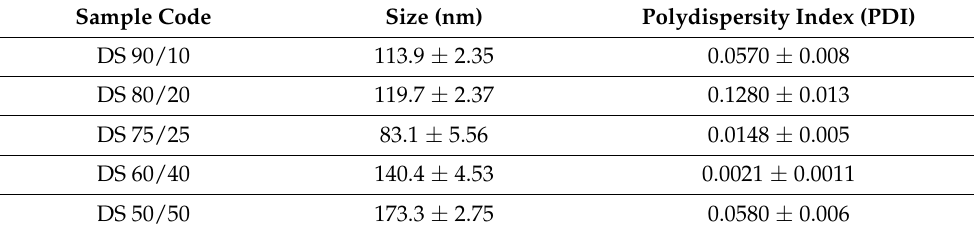
Table 3. Average particle size diameter and polydispersity index values of the latexes.